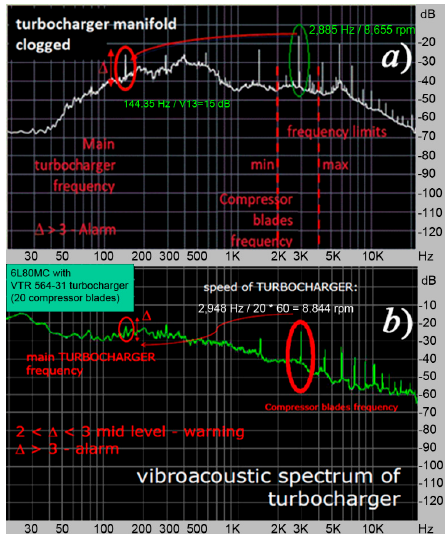
Figure 5. Acoustic spectrum of the VTR 564 turbocharger before ( a ) and after ( b ) manifold cleaning. The measurements made on the engine before the exhaust system cleaning gave a main harmonic frequency equal to 144.35 Hz, which was calculated from the blade fre- quency of the spectrum. It is clear that a main harmonic amplitude greater than 15 dB exceeded the general spectrum level (Figure 5a). This increased level of the main harmonic amplitude was caused by the vibrations of the turbocharger rotor at the frequency of its rotation. The reason was dust, oil, and carbon deposits on the turbine nozzle and exhaust manifold walls, which distorted the gas flow path and caused vibrations in the turbo- charger rotor. Cleaning and revision of the exhaust manifold and turbine side of the turbocharger allowed the main harmonic amplitude to be lowered down, as shown in Figure 5b. It is obvious that the level of the main harmonic amplitude was equal to the signal noise level in this case. By scaling the spectrum diagram (Figure 5b), the value of blade frequency was esti- mated as 2948 Hz—it was the closest harmonic to the top limit of 3 kHz. The left harmonic in the diagram (respective to the blade harmonics) is the sub-harmonic, which had a fre- quency two times smaller, 1474 Hz.